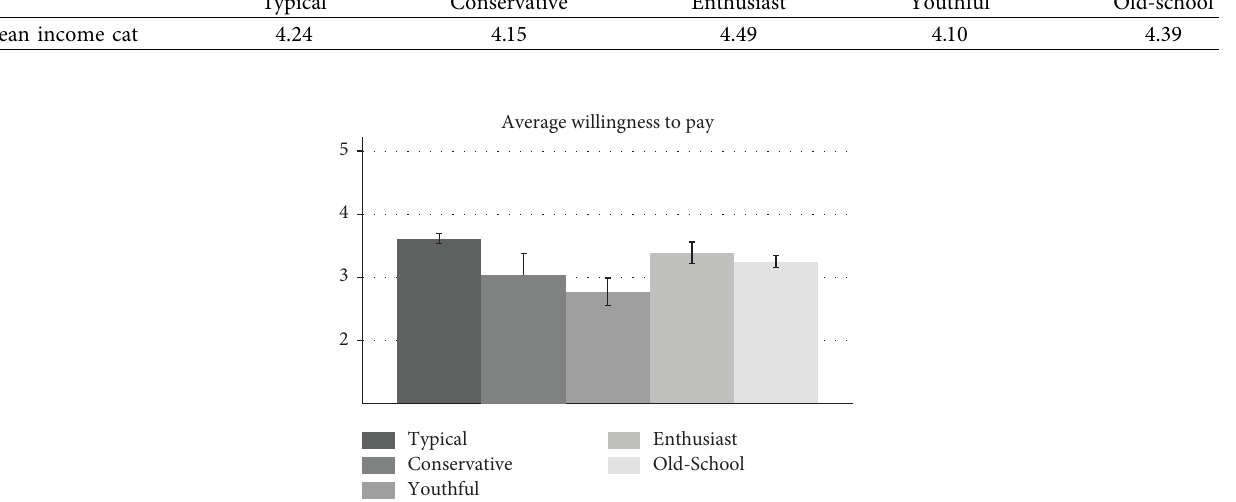
Figure 6: Average willingness to pay for CAC with all automated driving functions (motorways, congested motorways, urban roads, and parking areas). Tin vertical lines represent the 95% confdence